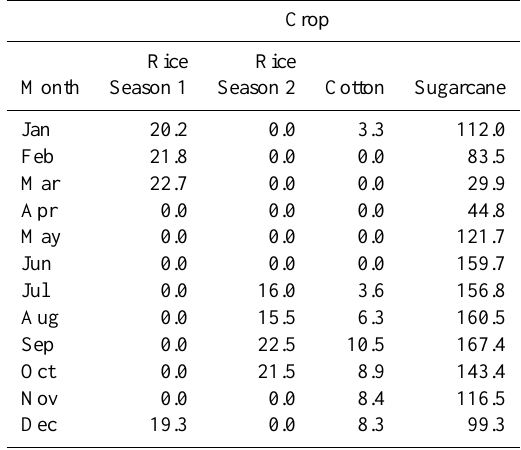
Table A2. Monthly demands for proposed irrigation crops in the Tana Delta (in m 3 s − 1 ) (Kiptala, 2008) applied only in the proposed demands case according to the proportions determined by related decision